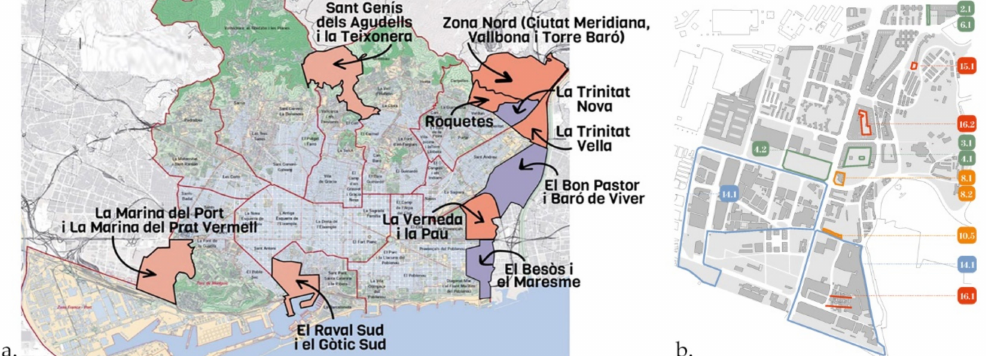
Figure 8. ( a ) Areas included in Barcelona’s Neighborhood Plan. ( b ) Detailed map of interventions in the Marina del Port neighborhood. Source: Foment Ciutat